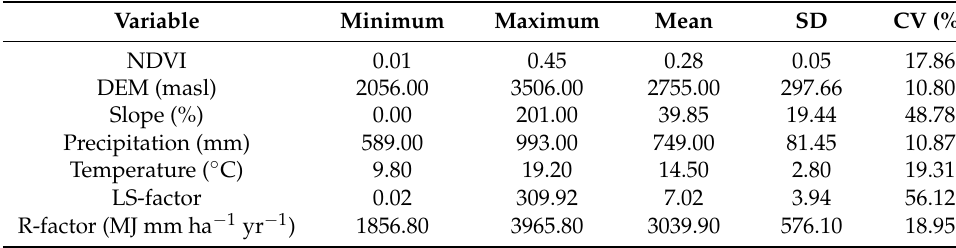
Table 3. Summary of the environmental variables in forested